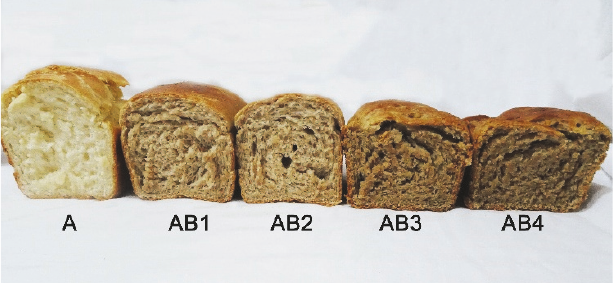
Figure 1: It shows the sensory evaluation of bread. Wheat flour 100% (A), wheat flour 80% and walnut flour 20% (AB1), wheat flour 70% and walnut flour 30% (AB2), wheat flour 60% and walnut flour 40% (AB3), and wheat flour 50% and walnut flour 50%